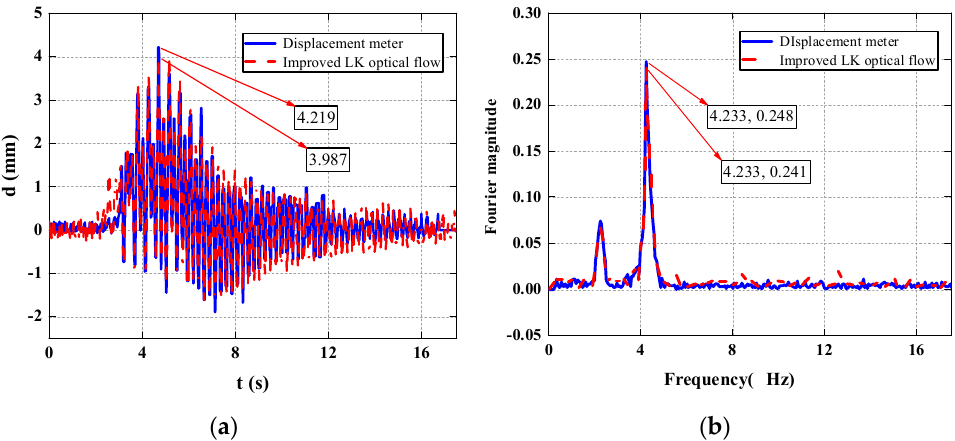
Figure 10. Mid-span displacement comparison chart. ( a ) Displacement time-history comparison chart; ( b ) displacement frequency-domain comparison chart.